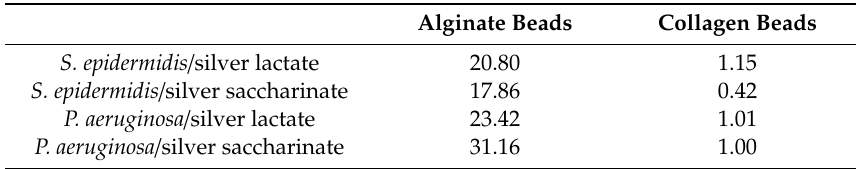
Table 2. IC 50 calculated for silver enriched alginate and collagen beads against S. epidermidis and P. aeruginosa and expressed as mM.